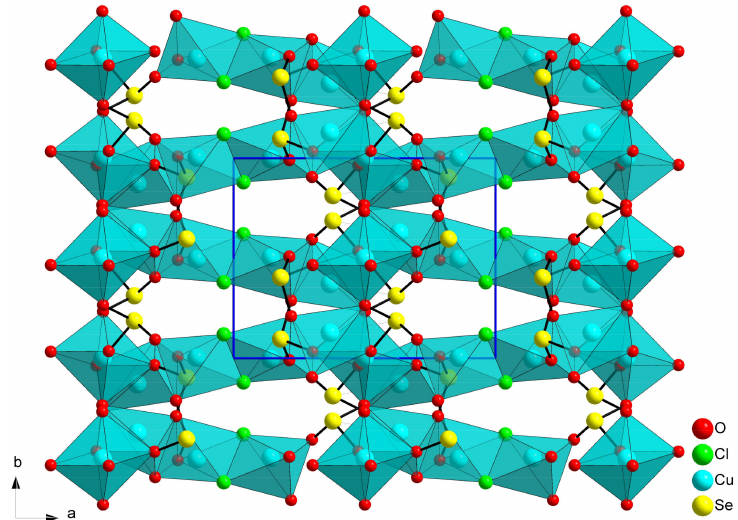
Figure 1. Projection of the Cu 5 (SeO 3 ) 4 Cl 2 crystal structure on ab plane according to [22]. Copper polyhedra are